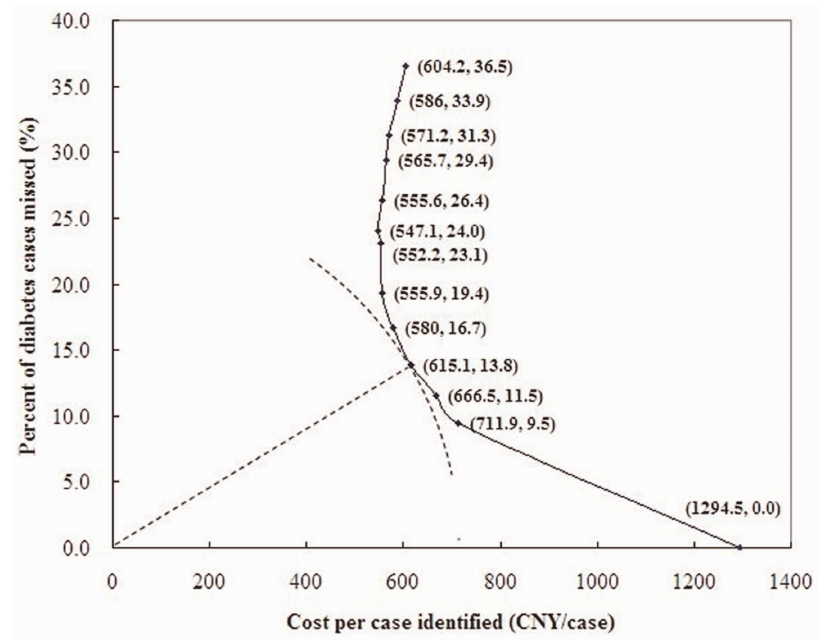
Figure 3. Percent of diabetes cases missed and cost per case identified by each screening strategy of FPG test combined with further OGTT test at different FPG cut-off